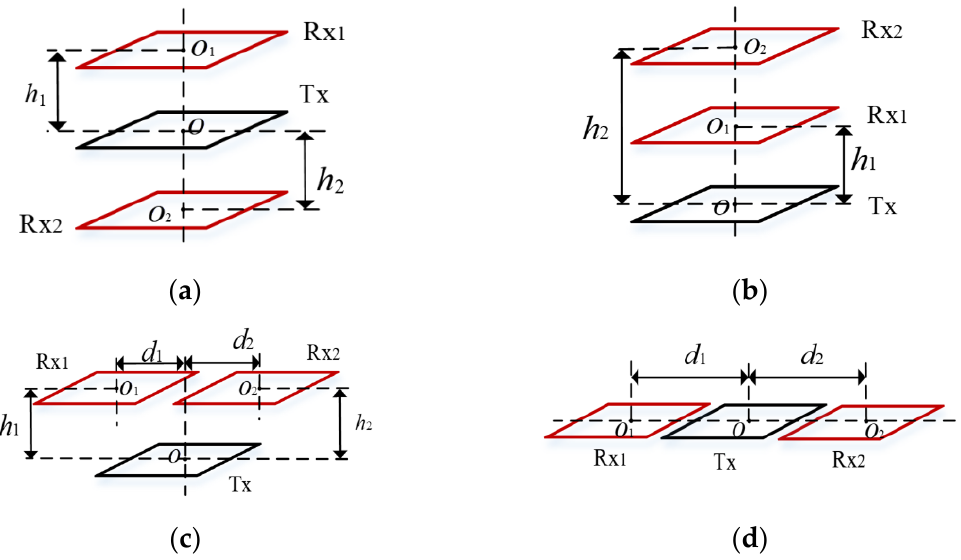
Figure 2. Spatial distribution of coupling coils. ( a ) Coaxial opposite side. ( b ) Coaxial same side. ( c ) Different axis same side. ( d ) Different axis